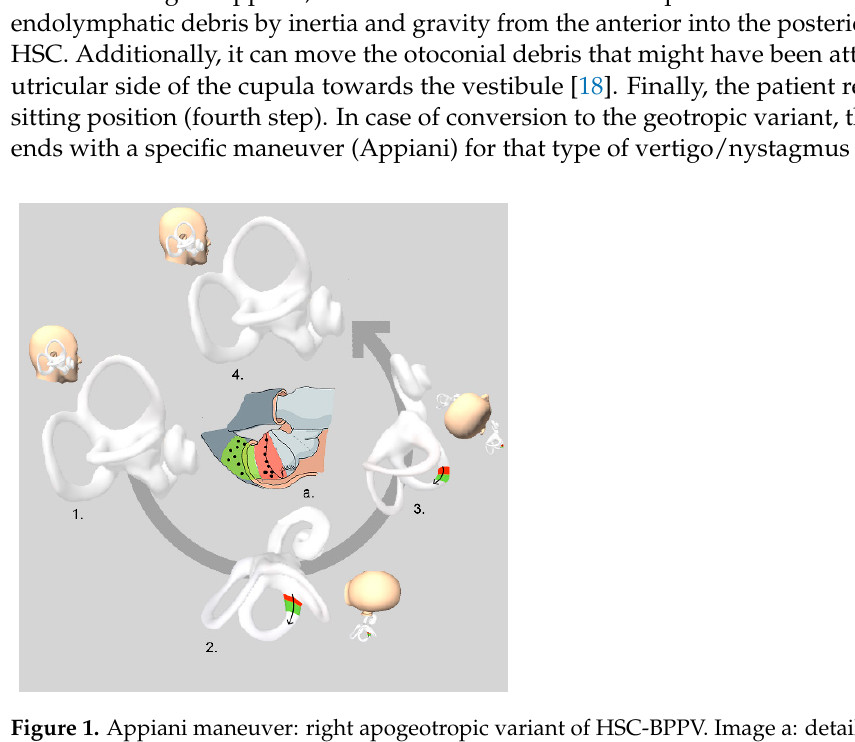
Figure 1. Appiani maneuver: right apogeotropic variant of HSC-BPPV. Image a: detail of horizontal canal cupulla. Red area: otoconia attached to the cupula facing the canal (C-CUP). Green area: free-floating otoconia in the anterior arm (anterior arm canalolithiasis)